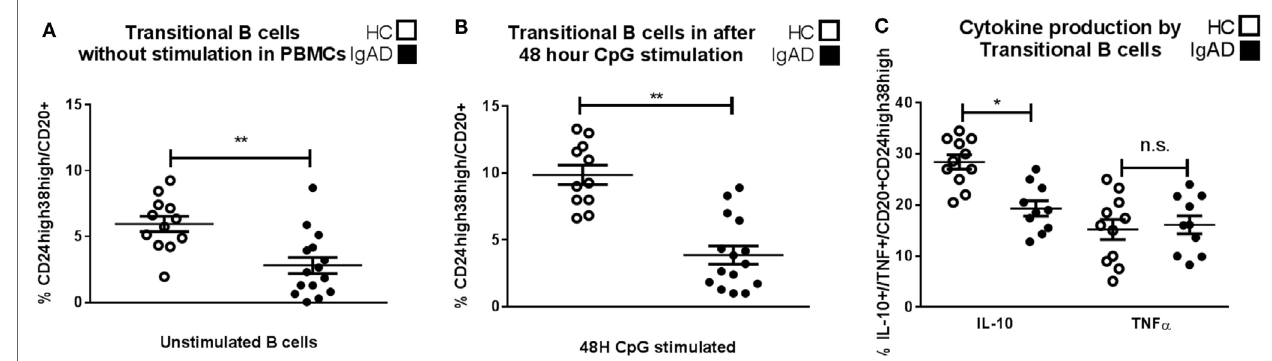
FigUre 2 | CD24 hi CD38 hi transitional B cells in selective IgA deficiency (IgAD) individuals are defective in their numbers, inducibility, and IL-10-secreting properties. The figure shows transitional B cells as measured ex vivo in PBMCs and after in vitro stimulation of B cells by CpG for 48 h and regulatory B cells (Bregs) as measured by flow cytometry comparing IgAD and controls. (a) B cells with a transitional B cell phenotype (CD24 hi CD38 hi ) are of lower fraction in IgAD individuals compared to healthy controls (HC) before stimulation and (B) after stimulation. Both IgAD and HC do though respond to CpG, as the fractions of the transitional population are increased after stimulation. (c) Evaluation of Breg function by the measurement of intracellular IL-10 demonstrate a lower fraction of IL-10 + Bregs (CD24 hi CD38 hi IL-10 + ) in IgAD compared to HC. A measurement of intracellular TNF- α in transitional B cells shows no difference between the two groups. In all figures, HC are depicted as white, while IgAD individuals are depicted as black bars. Data are shown as mean ± SEM of all IgAD and HC assessed. All data are from five-independent experiments, no duplicates. Significance was calculated in relation to the control group. * p < 0.05, ** p < 0.01, *** p < 0.001 (one sided Student’s t